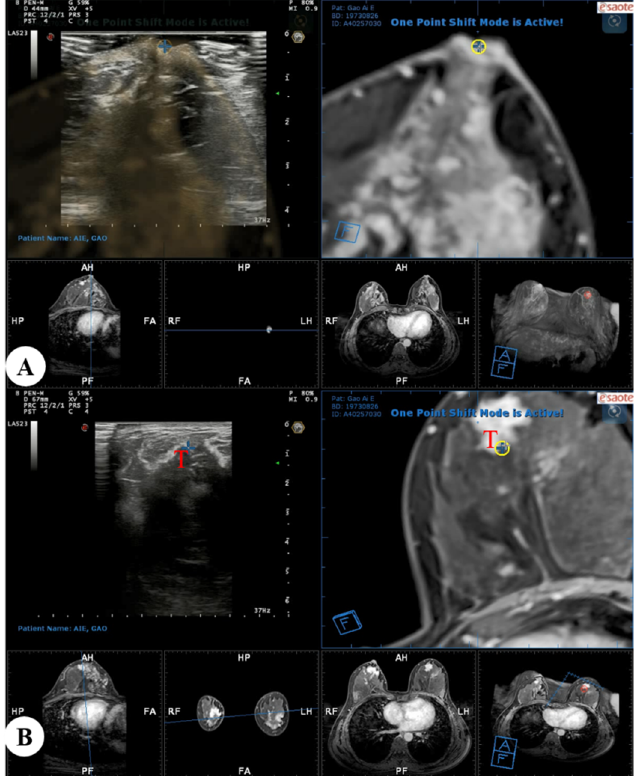
Figure 3. Real-time US with virtual navigation was performed in the prone position: ( A ) A co-registration process between real-time US and MRI-MPR images was performed with the nipple as a reference point, and the contour of the breast and internal anatomic landmarks were aligned; ( B ) Search and localization using real-time US with virtual navigation of the corresponding suspected enhanced lesion (T, target) identified on MRI alone. US = ultrasound; MRI = magnetic resonance imaging; MPR = multiplanar